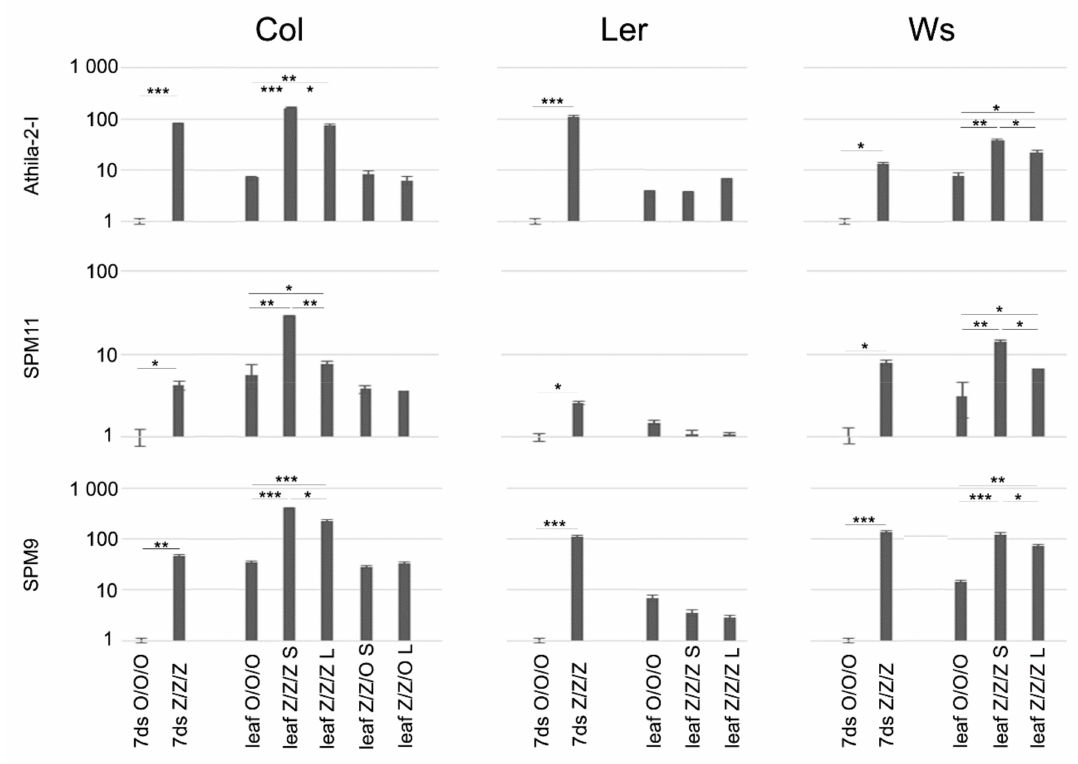
Figure 3. Relative levels of transcripts of selected TEs in seedlings of A. thaliana plants exposed repeatedly to 250 µ M zebularine during germinations and in leaves of plants grown from these seedlings. RNA was extracted using the NucleoSpin RNA kit (Macherey-Nagel) from 100 mg of 7-day-old seedlings and leaves of 8-week-old plants. Relative levels of transcripts in Z/Z/Z 7-day-old seedlings (7ds) and leaves were compared to levels detected in control organs (7ds O/O/O, leaf O/O/O/, for experimental design and nomenclature of samples, see Figure 1). S, plants with short telomeres and L, plants with long telomeres (see Figure 2a). Signals of TE transcripts were related to that of the ubiquitin10 reference gene, levels of TE transcripts in 7ds O/O/O samples were arbitrarily chosen as 1. Data were evaluated by two sample F-test and t-test. * p < 0.05, ** p < 0.01, and *** p < 0.001. Note the logarithmic scale at the y